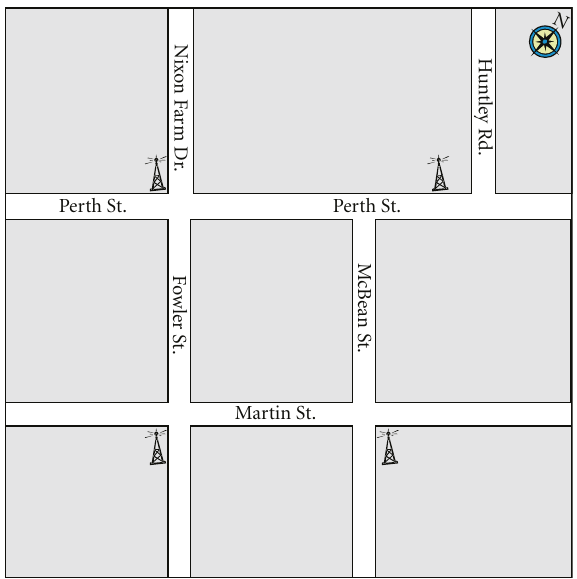
Figure 4: Urban scenario—Richmond,